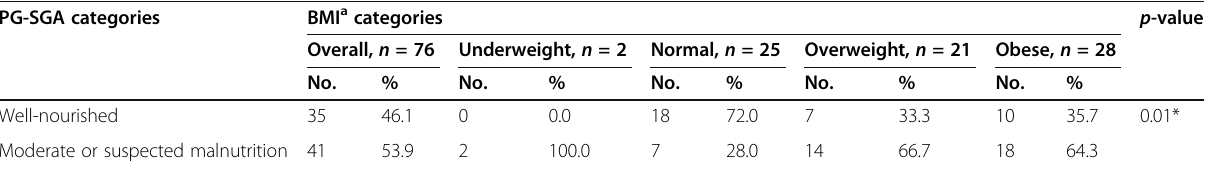
Table 1 Percent distribution of the studied multiple sclerosis patients body mass index and patient-generated subjective global assessment categories